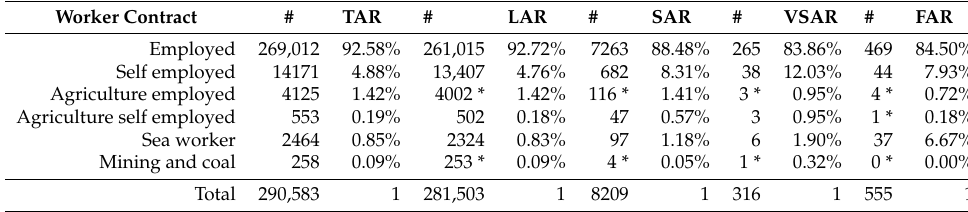
Table 5. Workers distribution by